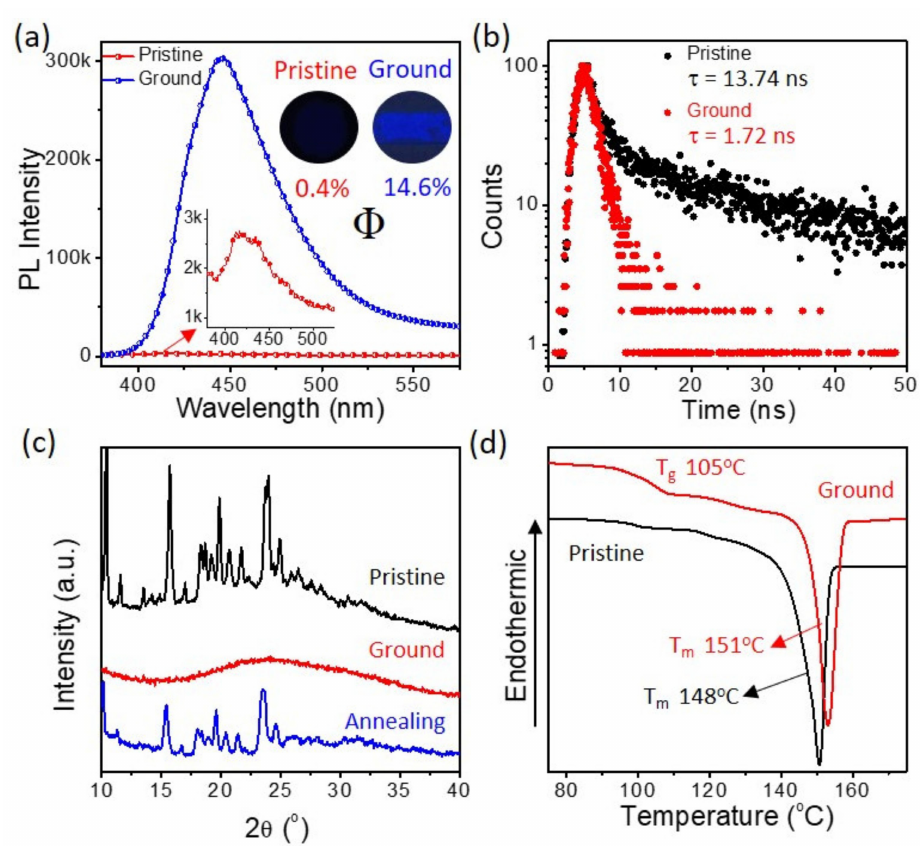
Figure 3. ( a ) PL, ( b ) TRPL, ( c ) XRD, and ( d ) DSC curves of BP-3-Cz in different solid states. The inset of ( a ) shows the corresponding Φ and fluorescence